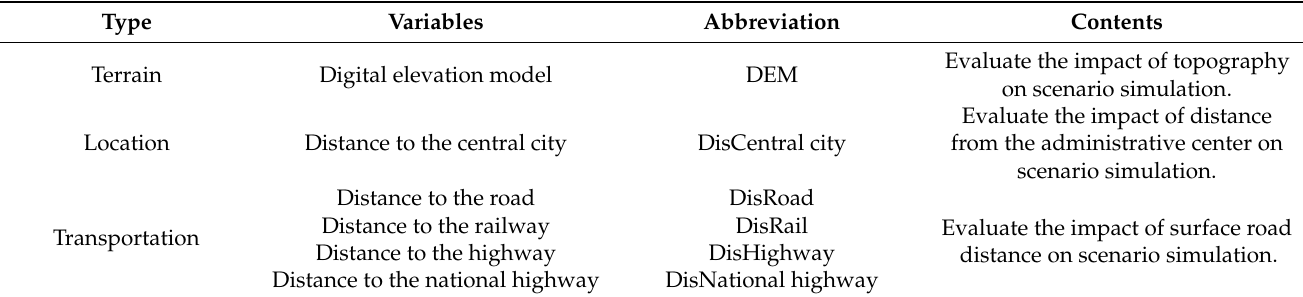
Table 3. Spatial variables of the urban growth